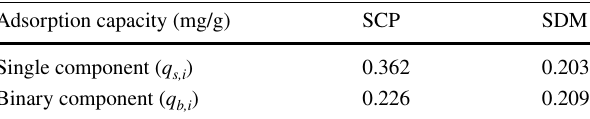
Table 7 Single and binary adsorption of SCP and SDM onto Fe-MC Adsorption capacity